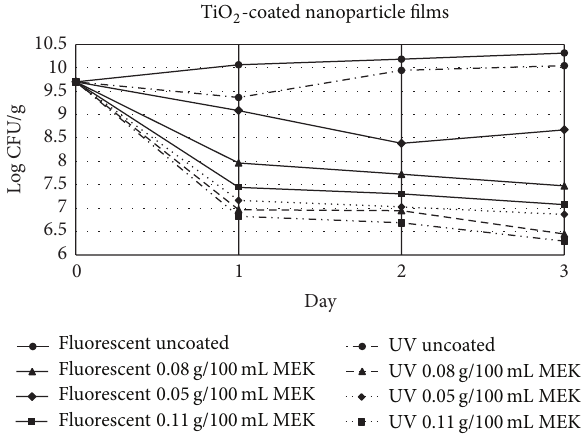
Figure 1: Antimicrobial activity of uncoated and coated films for various TiO 2 concentrations (0.05, 0.08, and 0.11g/100mL MEK) at designated interval times (1, 2, and 3 days) exposed to fluorescent and UV